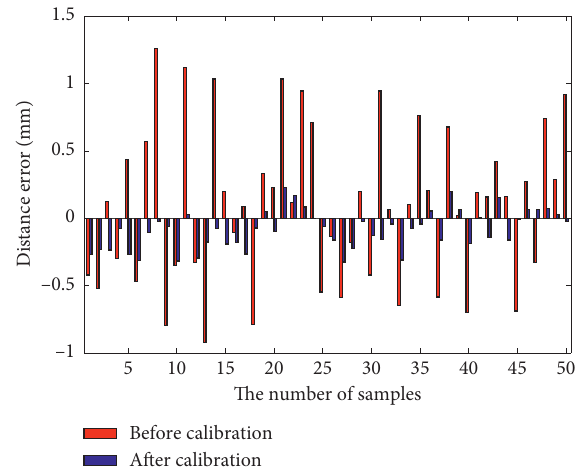
Figure 7: The distance error of the robot after compensation by EKF.